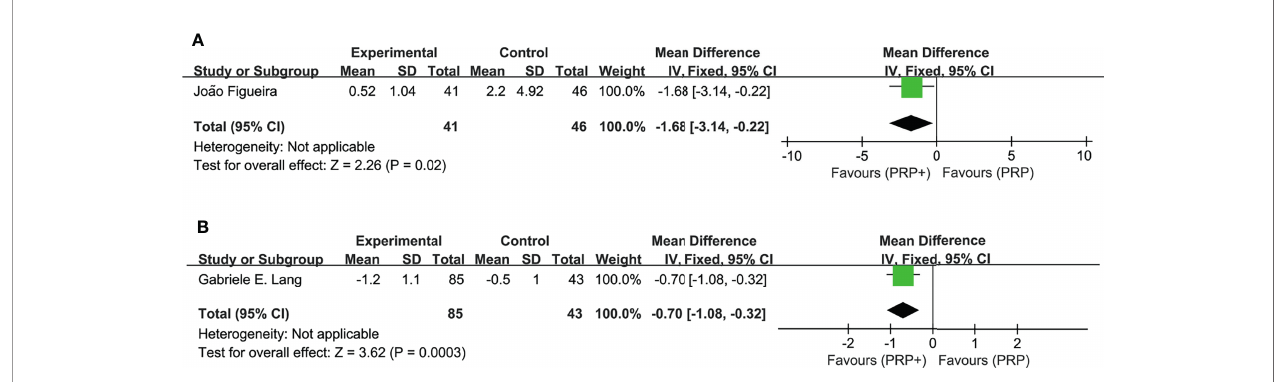
FIGURE 6 | Meta-analyses of PRP+anti-VEGF treatment and PRP monotherapy, comparing changes of NVT (DA) and total retinal volume (mm3). (A) NVT (DA). (B) Total retinal volume (mm3). Outcomes assessed: BCVA in studies that compared combination treatment with PRP monotherapy. The shaded area is the weight ofthe estimate in proportion to the overall effect.